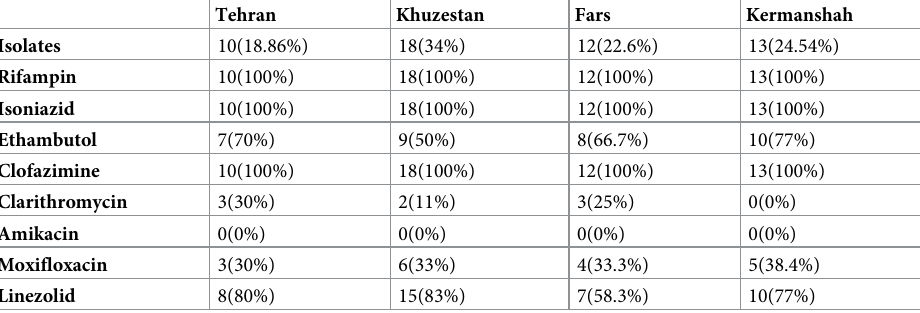
Table 6. The regions and geographic distribution of drug-resistant M . simiae strains.